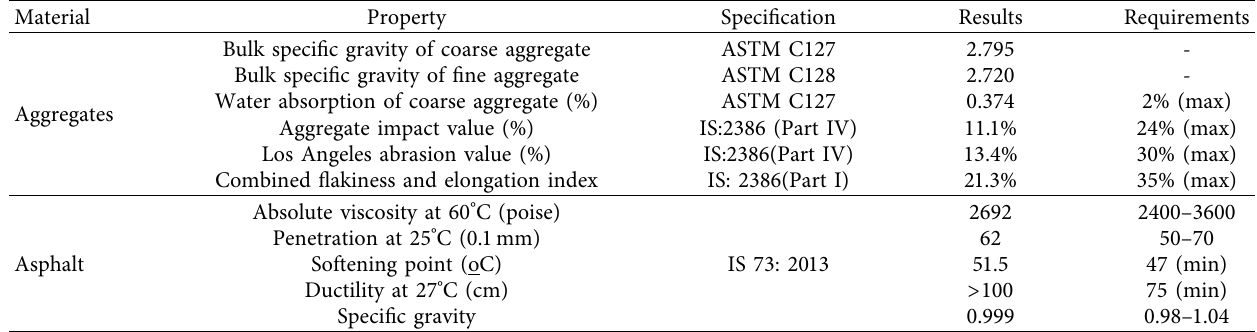
Table 1: Properties of aggregate and asphalt.